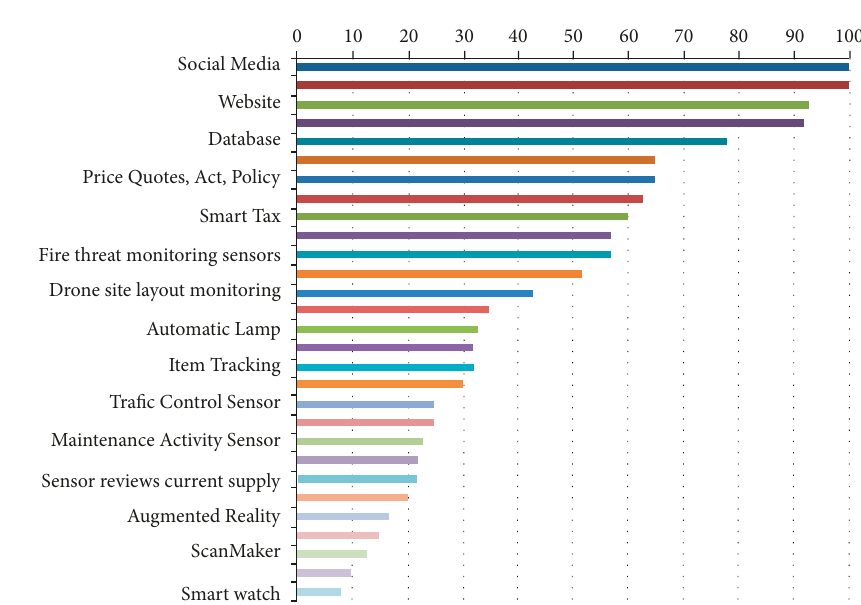
Figure 11: Summary of % usage of IoT in the construction